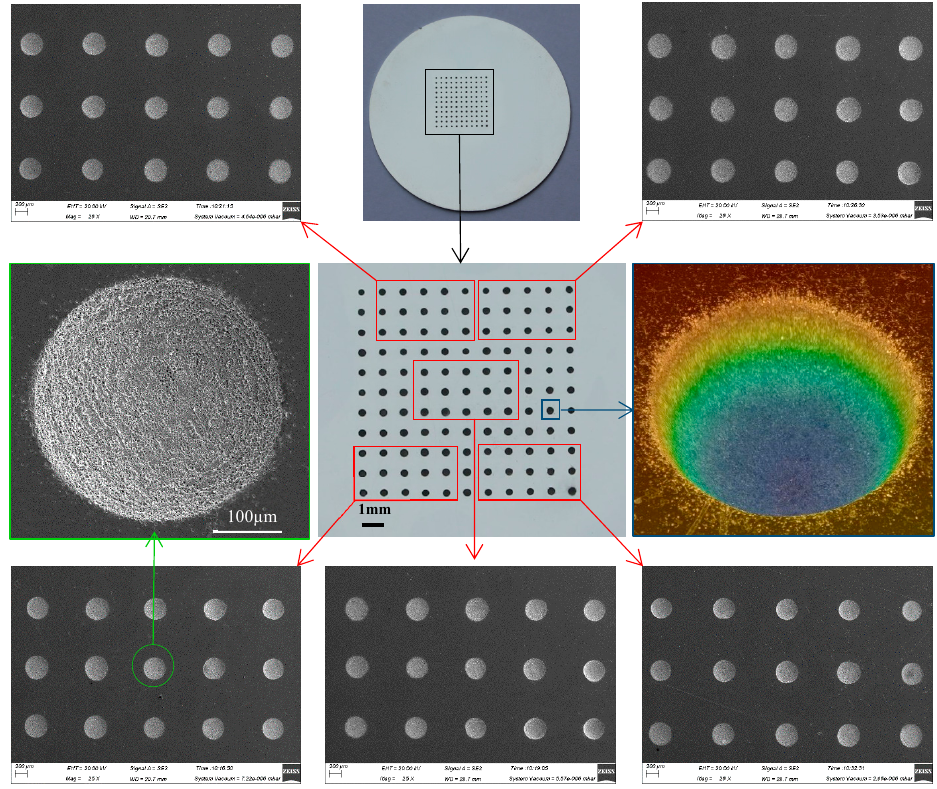
Figure 4. Morphologies of the arrayed micro-dimples machined in the single-travel mode and under the magnetic field (single-travel time of 0.3 s, 8.5 V).